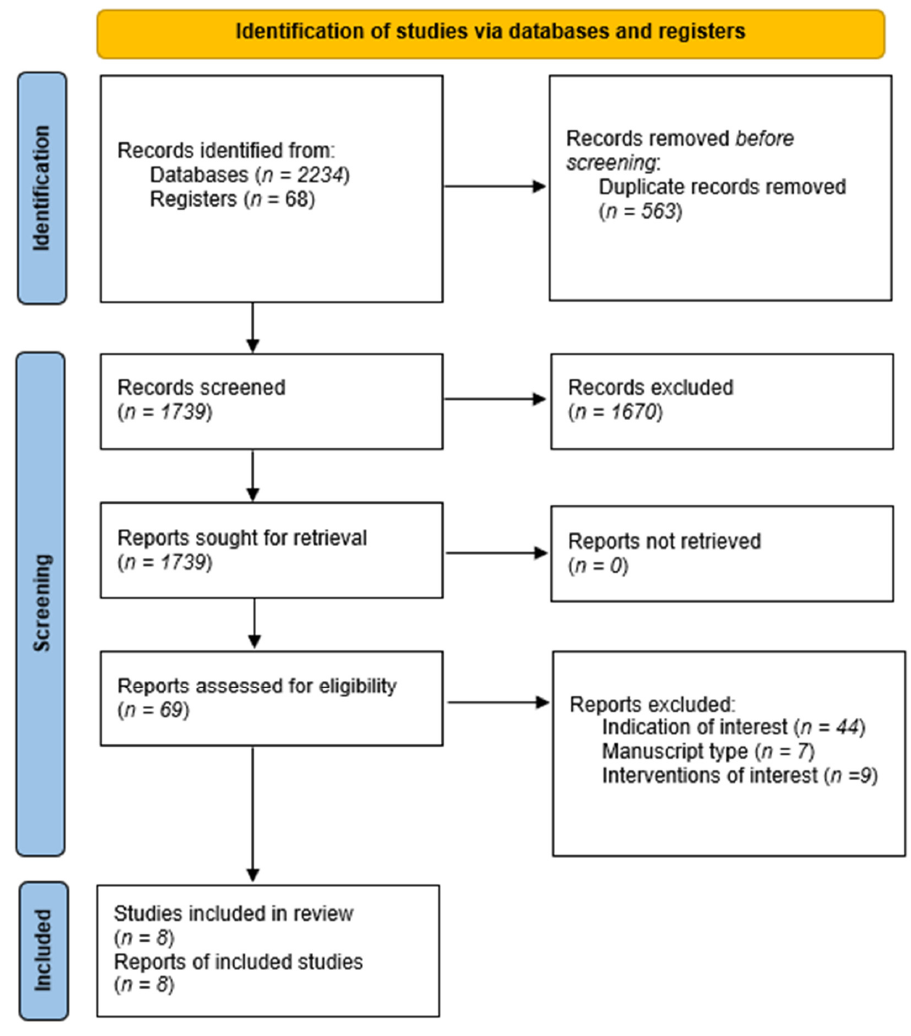
Figure 1. The study selection flow.